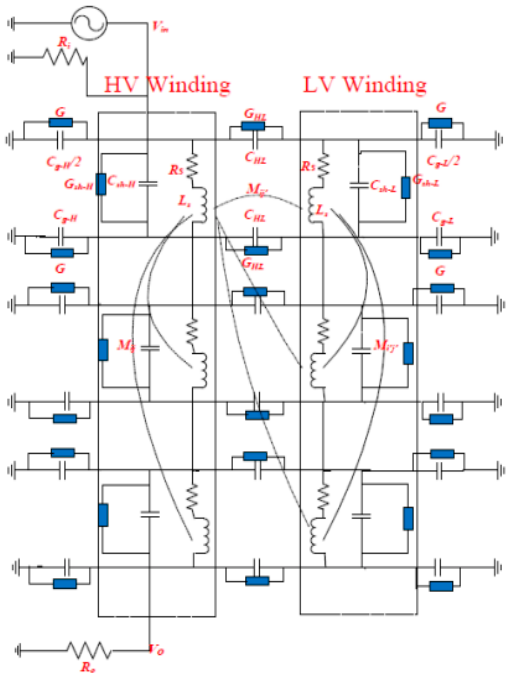
Figure 1. Transformer model [15]. HV: high voltage; and LV: low voltage. Energies 2016 , 9 , 879